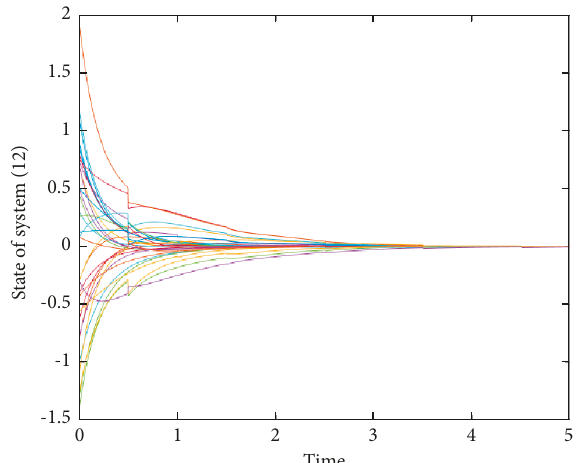
Figure 7: The state diagram of 8 nodes of system (14) when α